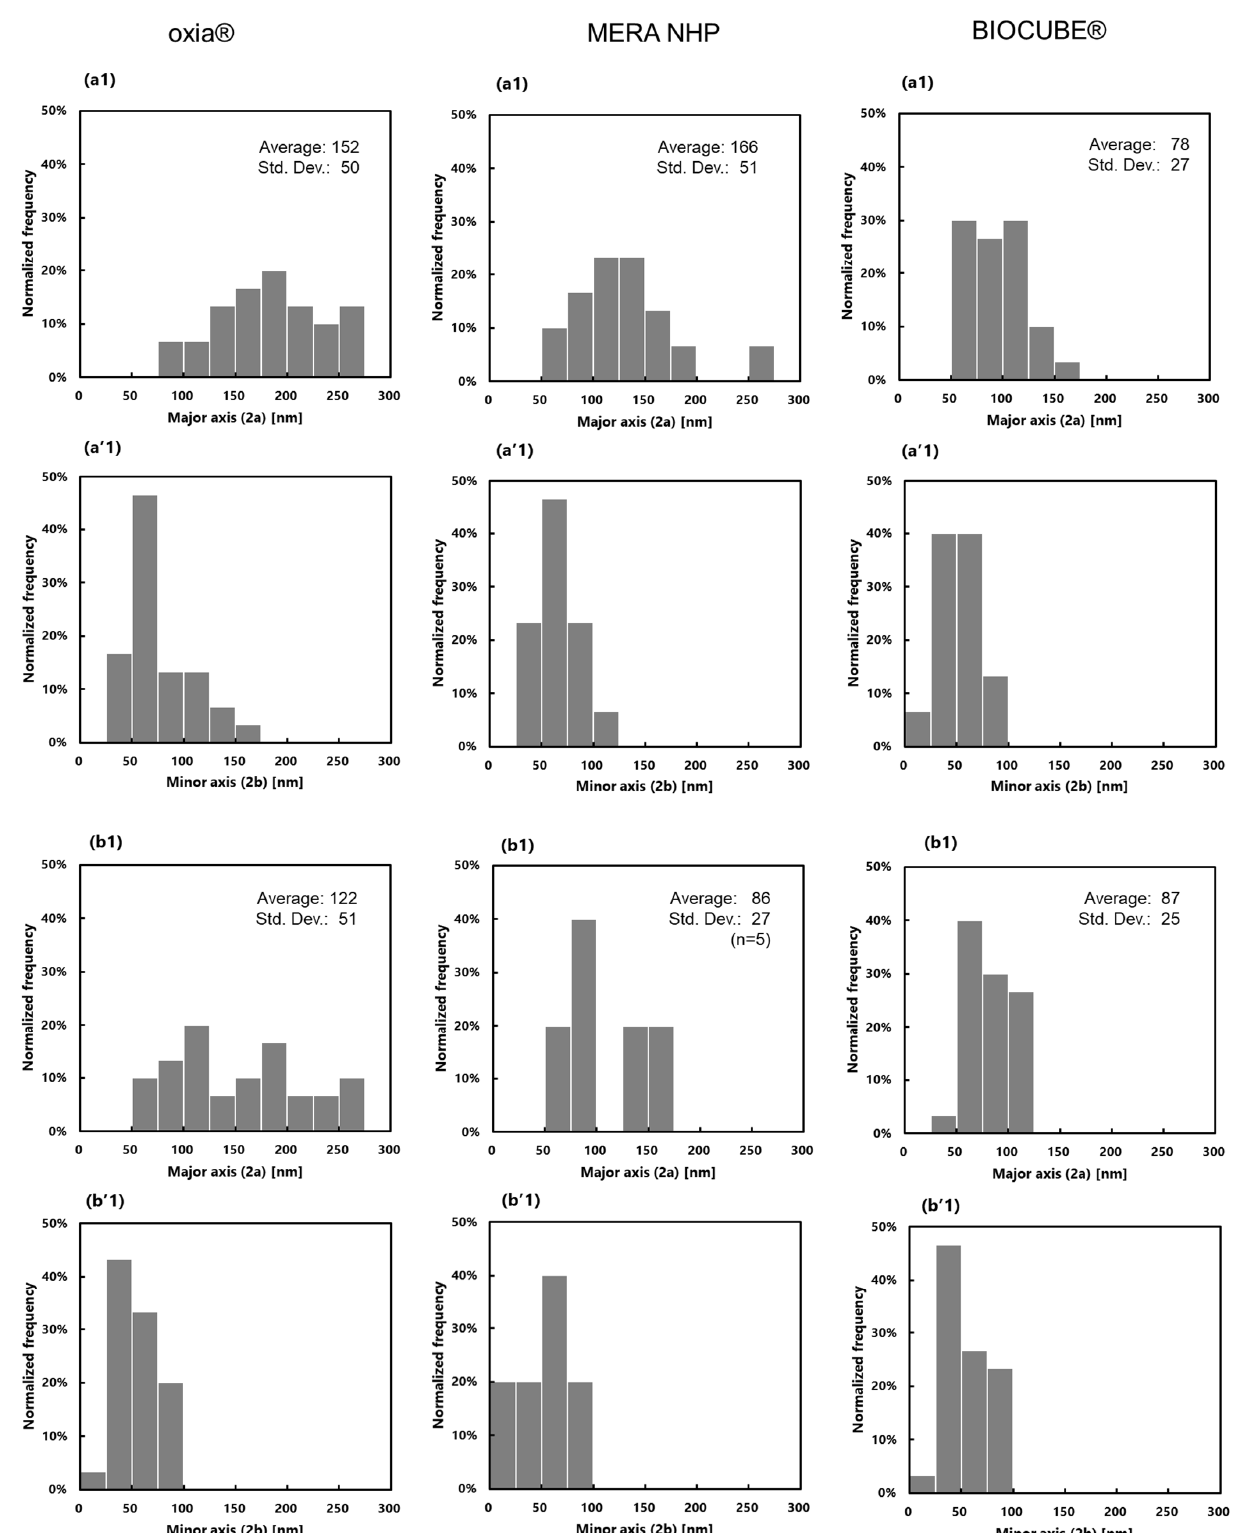
Figure 8. Distribution of the ellipse pore diameter of three membranes (dry), determined via FE-SEM, ( a ) the surface of inner lumen of the capillary membranes and ( b ) the outer surface of the capillary membranes. ( a1 , b1 ) Major axis (2a), ( a’1,b’1 ) Minor axis (2b).